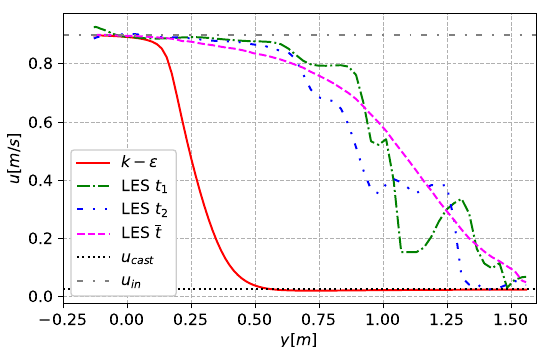
Figure 16. Velocity field at